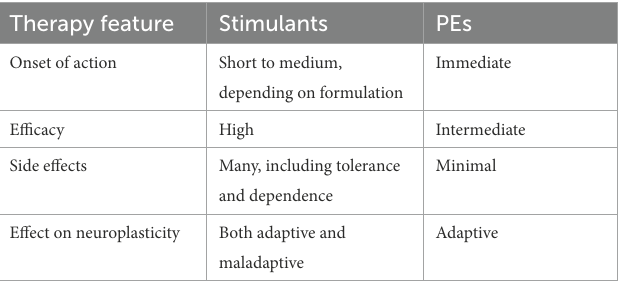
TABLE 1 Comparison between two therapeutic approaches to manage ADHD. Therapy